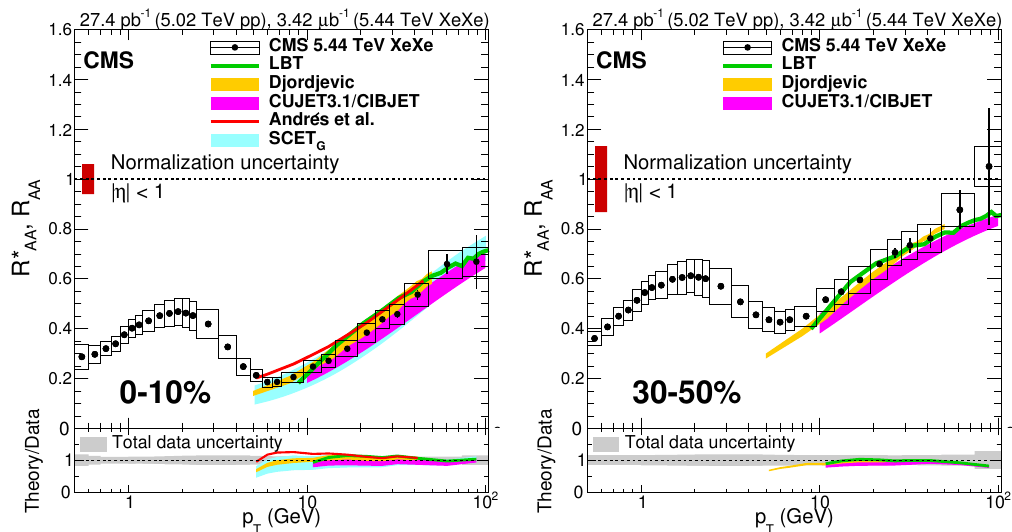
p for XeXe collisions at s = 5 : 44 TeV with AA NN